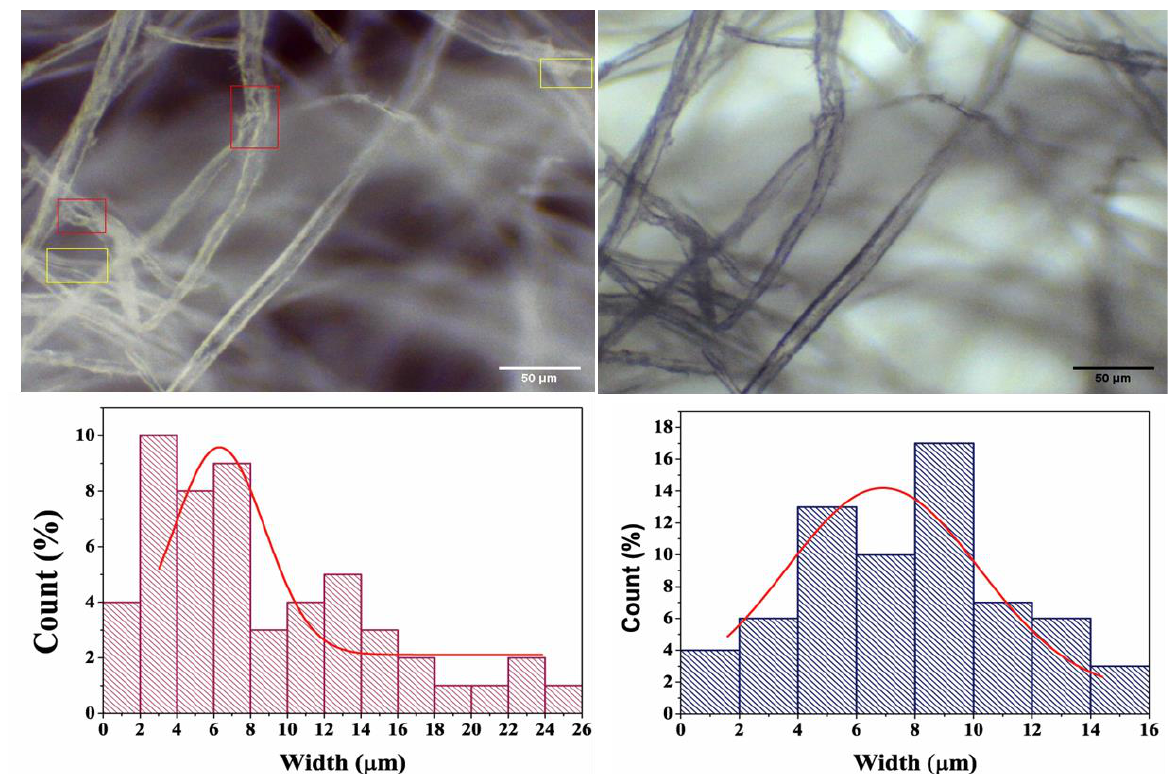
Figure 5. Microscopic images of the different samples: Cellulose microfiber (CMF) (left), and cellulode microfiber plant extract encapsulated (CMF-E) membrane (right), and the corresponding fiber size distributions. The red and yellow selected areas in top left figure are the smallest fiber regions.